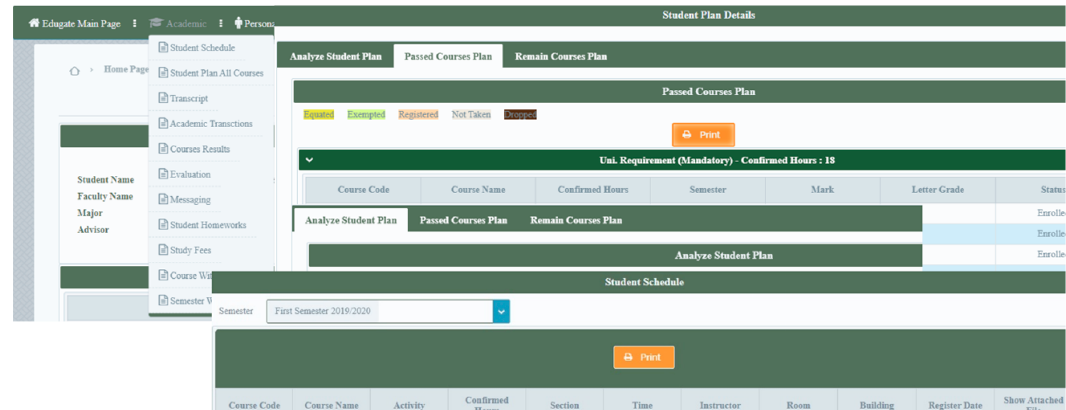
Figure 2. The structure of EAR—Example 1.